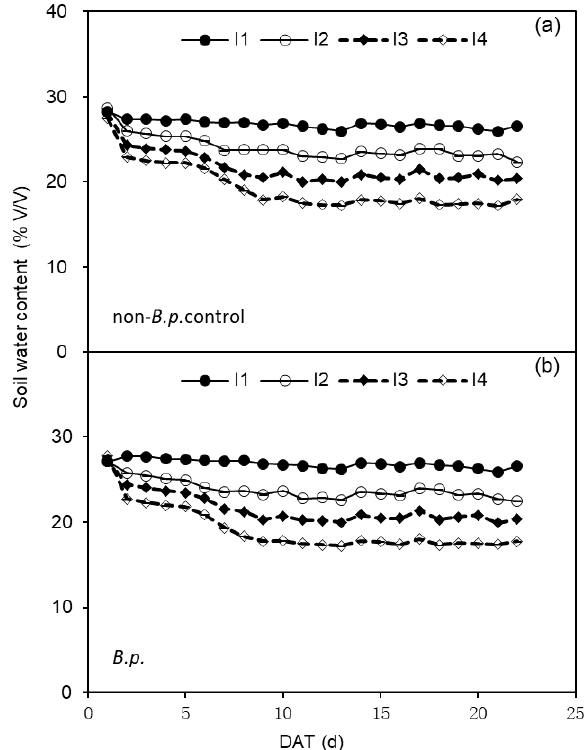
Figure 4. Change of soil water content (%, v / v ) in the pots of tomato subjected to four irrigation regimes (I1 — irrigated to 35% ( v / v ) SWC; I2 — irrigated to 30% SWC; I3 — irrigated to 25% SWC; and I4 — irrigated to 20% SWC) without or with Bacillus pumilus (non- B.p. control or B.p. ) inoculation. ( a ) and ( b ) in the figure are corresponding to SWC of non- B.p . control and B.p . plants, respectively.